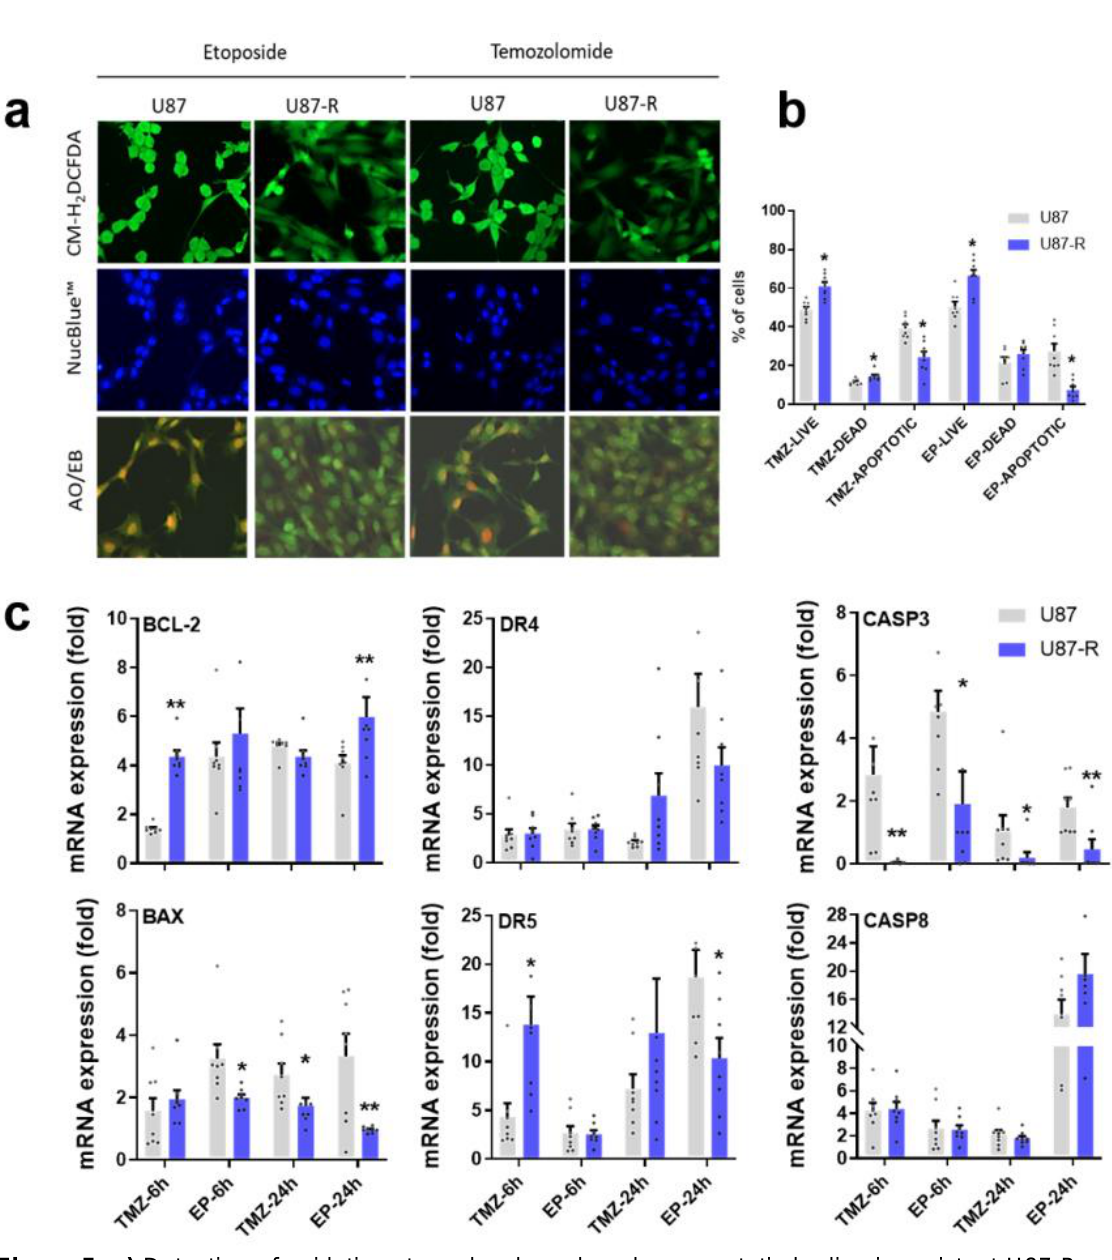
Figure 5: a) Detection of oxidative stress levels and nuclear apoptotic bodies in resistant U87-R and non-resistant U87 cells after treatment with etoposide (EP) and temozolomide (TMZ) at IC doses; cells 50 were labeled with CM-H DCFDA and stained with acridine orange–ethidium bromide (AO/EB) and Nuc- 2 blue. b) Percentages of live, dead, and apoptotic cells among U87-R and U87 cells treated with EP and TMZ at IC doses; cells were stained with annexin V/propidium iodide (PI) and states tallied using a 50 Tali image-based cytometer. All percentages are given as mean ± SE, n = 8. *indicates significantly dif- ferent values compared to respective vehicle-treated control, determined by one-way ANOVA and the Tukey HSD test ( p ≤ 0.05). c) Relative fold changes of BCL-2 , BAX , DR4 , DR5 , caspase-3, and caspase- 8 genes in EP- and TMZ-treated U87-R and U87 cells as determined by quantitative real-time PCR. All data were normalized to β-actin and GAPDH expression and are given relative to control (control=1, not shown in figure). Data are presented as mean ± SE, n = 8. *indicates significantly different values in U87-R vs U87 groups, Mann-Whitney U test: * p ≤0.05; ** p ≤0.01; Control: vehicle-treated control; TMZ: temozolomide, IC : 250.2 μM; EP: etoposide, IC : 6.49 μM. U87 50 50